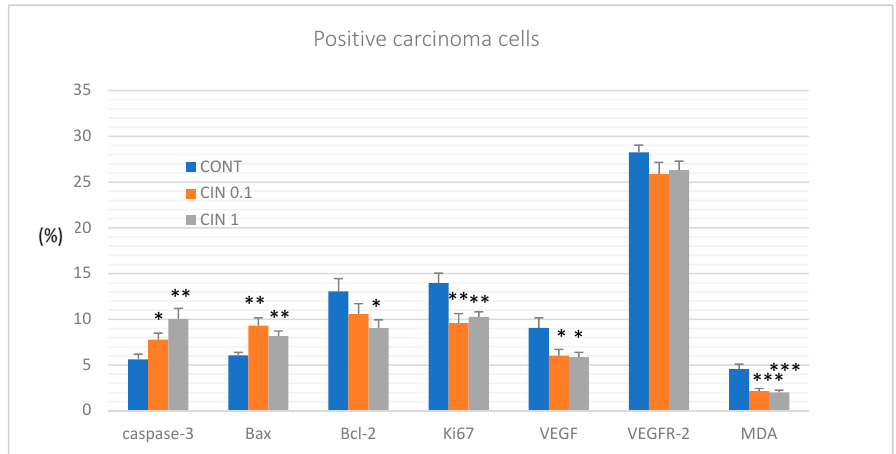
Figure 4. Immunohistochemical evaluation of caspase-3 (cytoplasmic), Bax, Bcl-2, Ki67, VEGFA, VEGFR-2, and MDA expression in rat mammary carcinoma cells after the administration of C. zeylanicum in two doses. Data are expressed as mean ± SEM. Significant di ff erence, * p < 0.05, ** p < 0.01, *** p < 0.001 vs. CONT. Figures represent the expression of proteins quantified as the average percentage of antigen positive area in standard fields (0.5655 mm 2 ) of tumor hotspot areas. The values of protein expression were compared between treated (CIN 0.1, CIN 1) and non-treated (control) carcinoma cells of female rats; > 60 images for one marker were